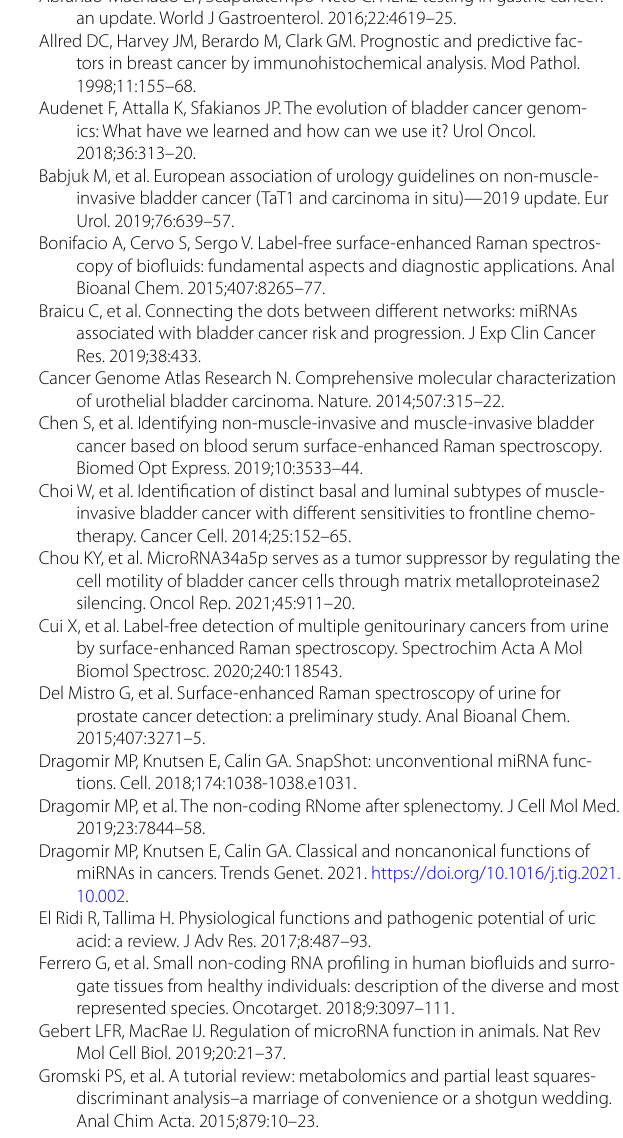
principal components (PC)), or a combination of the two (miRNA SERS). + Table S11 . Immunohistochemistry-based analysis of the included BC patients. Table S12. Differentially expressed urinary miRNAs between luminal and basal type bladder cancer patients. Table S13 . The diagnostic ability to distinguish the luminal type and basal type bladder cancer with the three classification algorithms (naïve Bayes, logistic regression, and random forest) run on datasets consisting of top three differentially expressed miRNAs alone (miR-204-5p, miR-615-3p, and miR-185-5p), SERS data alone, or a combination of the two (miRNA SERS). + Additional file 2: Table S6. A The list of gene sets significantly enriched in targets of miRNAs downregulated or upregulated in the differential expression analysis between cases and controls. B List of the validated miRNA-target interactions used for the enrichment analysis (Table attached as an additional Excel